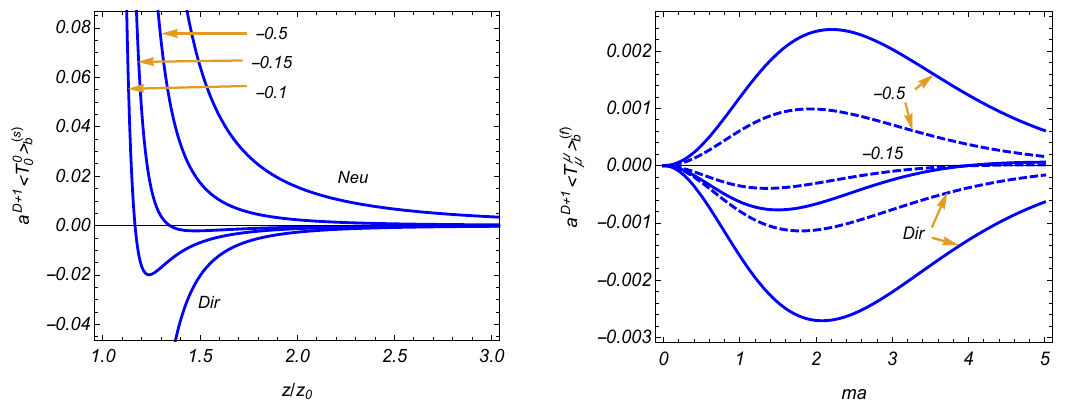
Figure 3. The same as in Figure 2 for D = 4 conformally coupled scalar field: ( left ) ma = 2; and ( right ) z / z 0 =